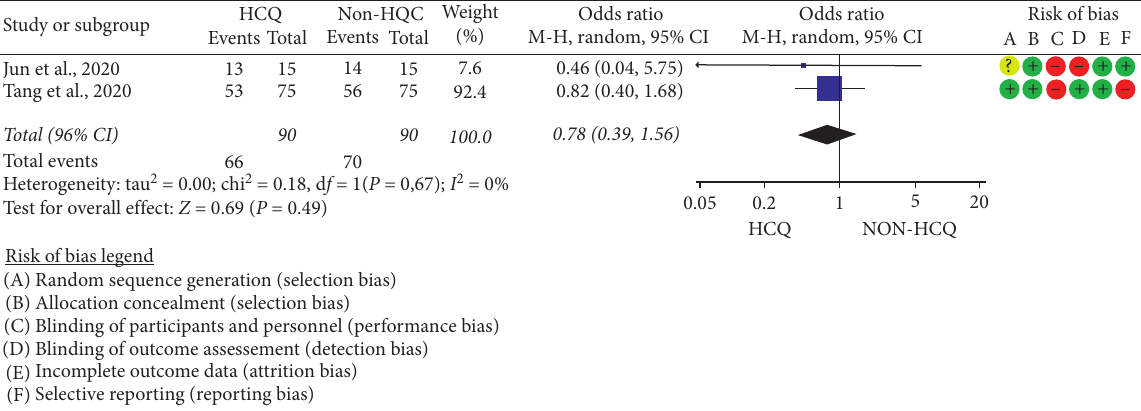
Study or subgroup